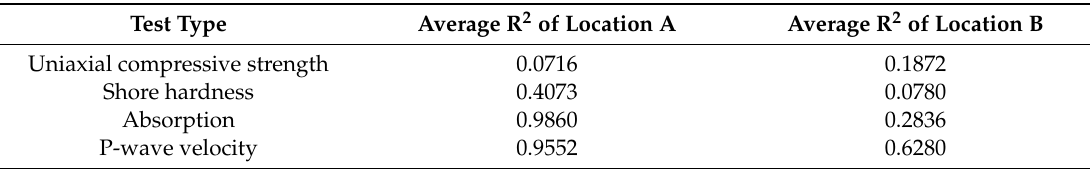
Table 4. Variation of R 2 due to freeze-thaw